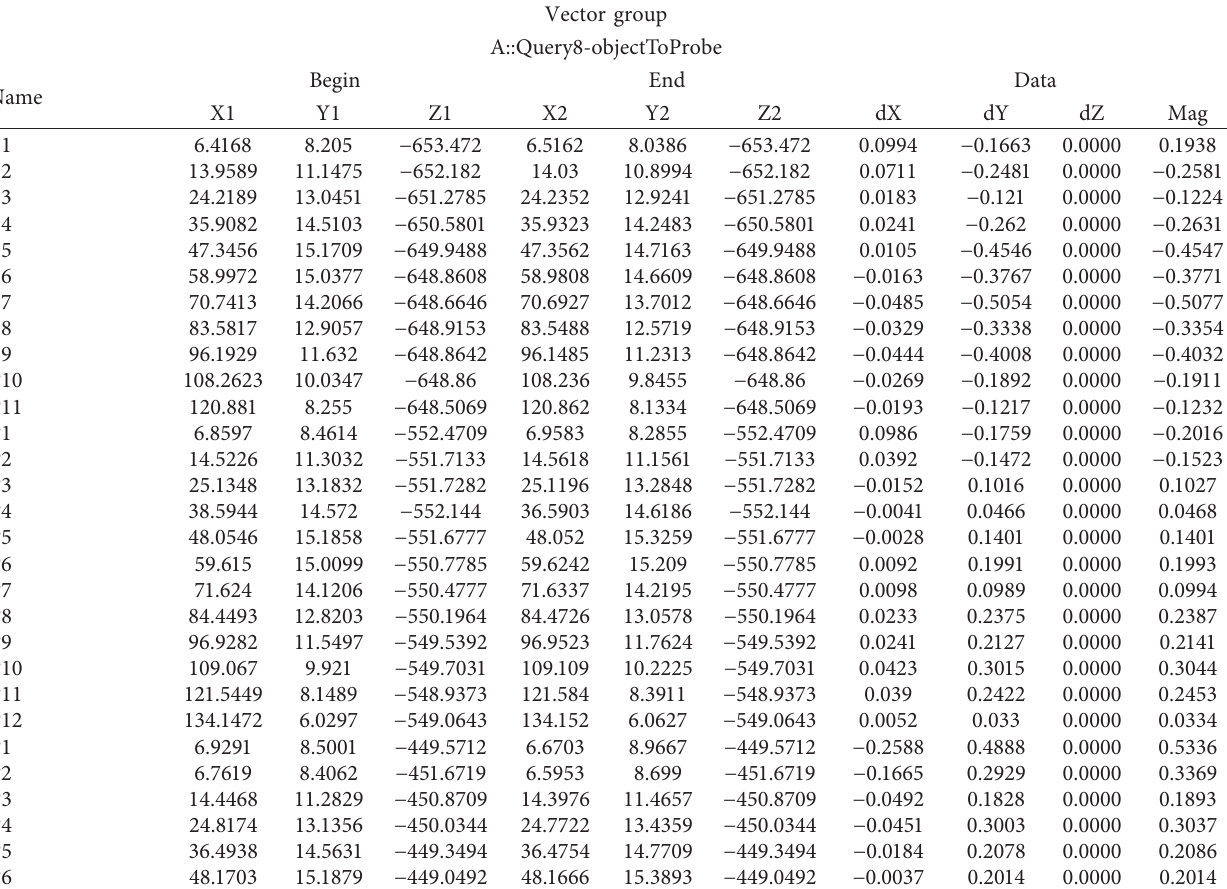
Table 6: Measurement between the measured points and